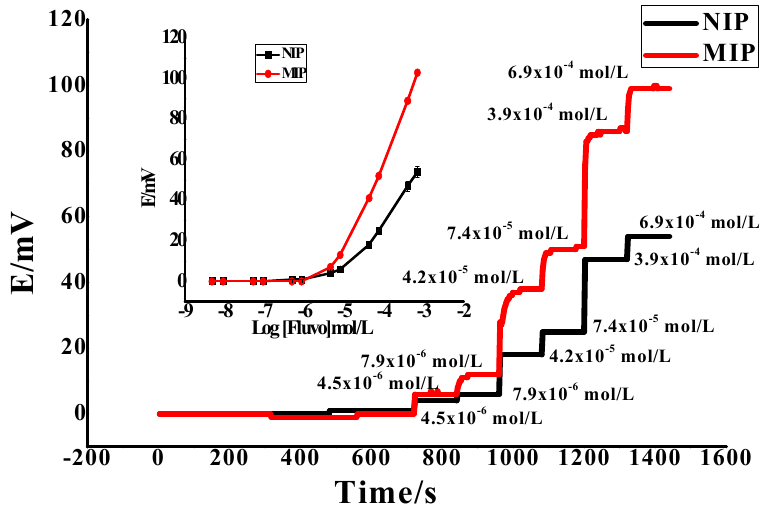
Figure 5. The potentiometric and time response of non-imprinted polymer (NIP) and the proposed sensor (MIP = 12, TPB − = 2.0, PVC = 68 and DOP = 118 mg) in phosphate bu ff er (0.01 M) pH = 6 with MWCNT as a transducer.